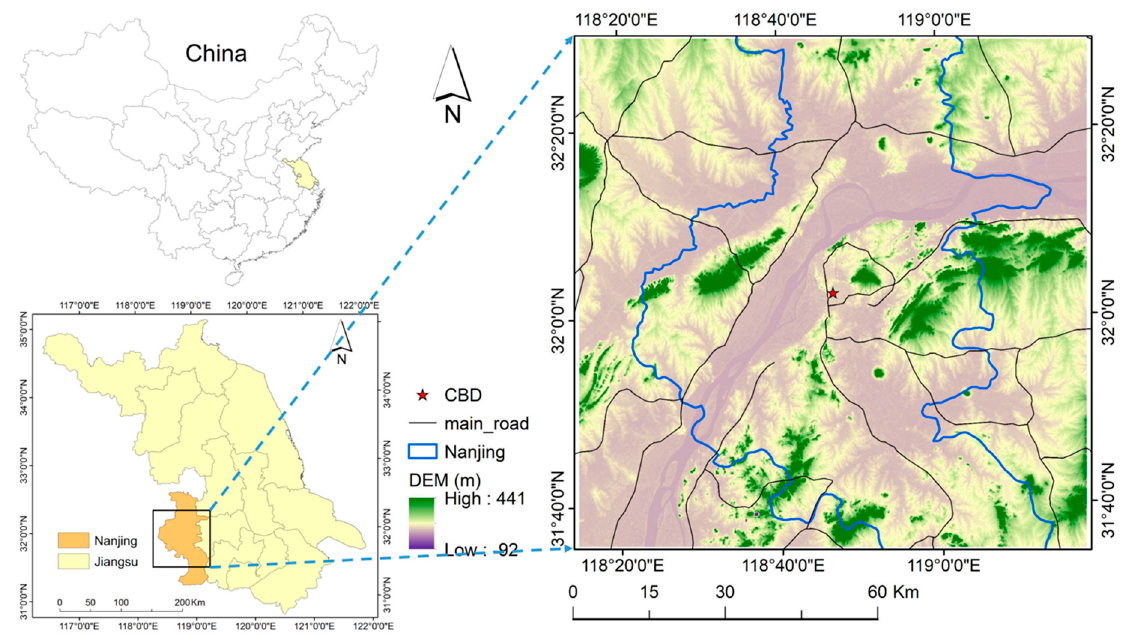
Figure 1. Location map of Nanjing.